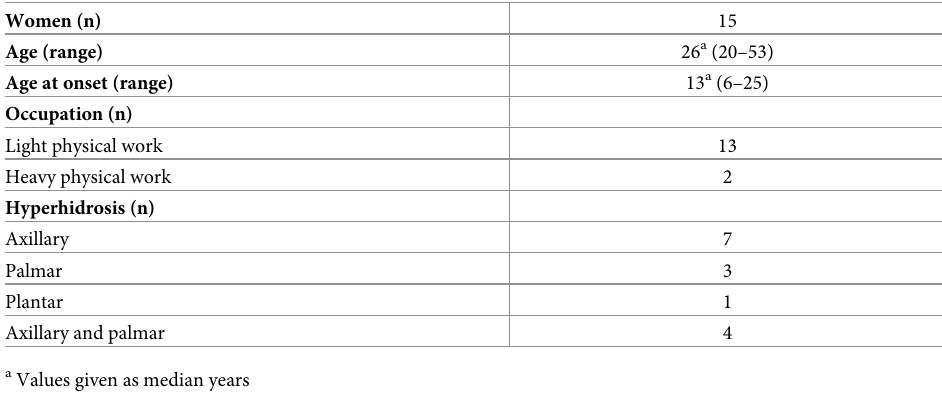
Table 1. Characteristics of women